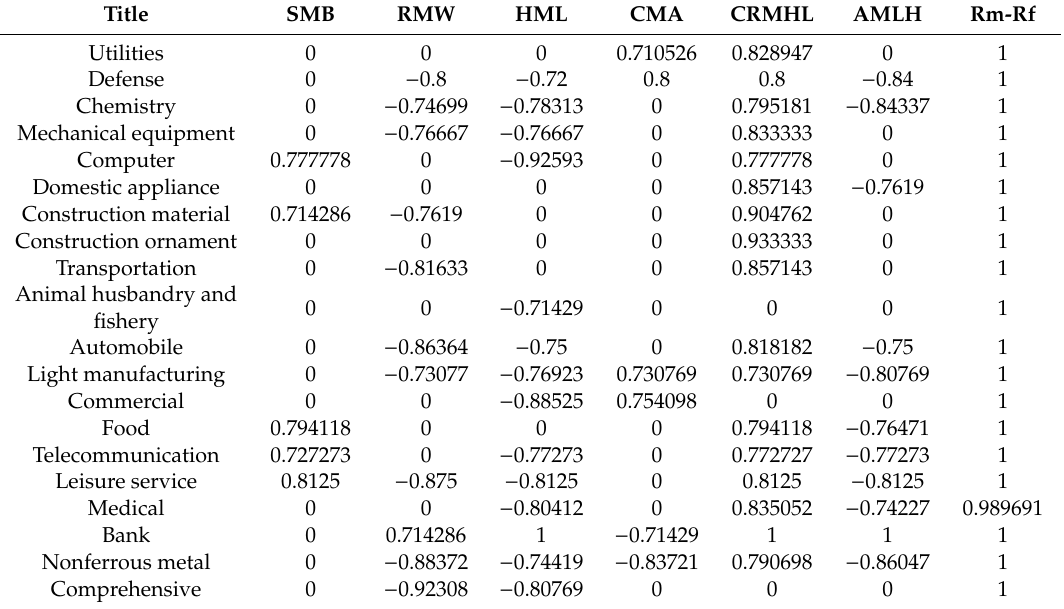
Figure A10. Use RMW to forecast the direction of RMW. Figure A11. Use CMA to forecast the direction of CMA.